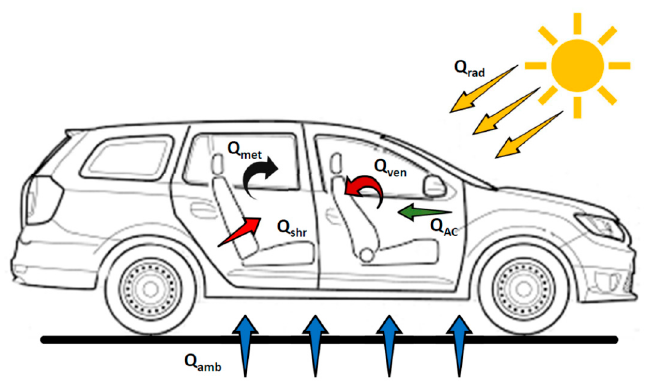
Figure 5. Thermal loads of a vehicle (schematic representation).